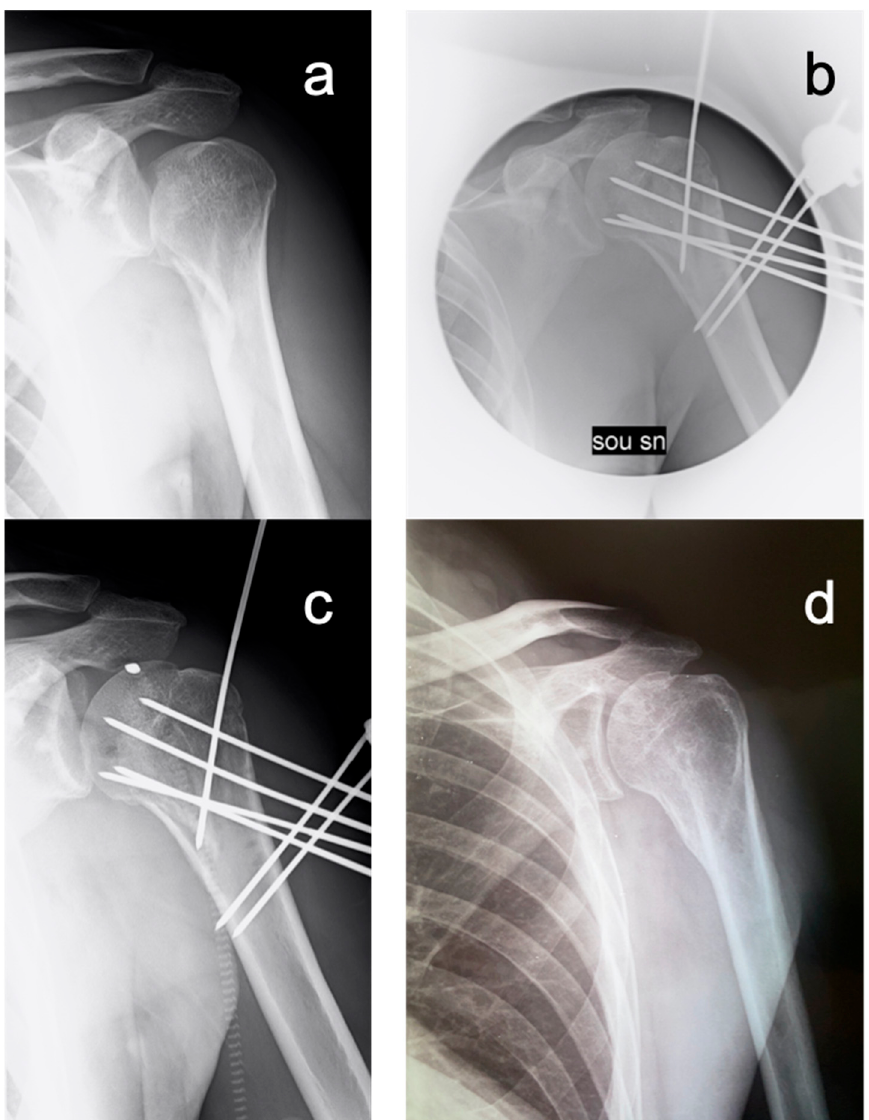
Figure 4. 53ys male patient who sustained a left three-part posterior fracture-dislocation of the humeral head. ( a ) Preoperative X-ray; ( b ) Postoperative X-ray; ( c ) 45 day-FU X-ray; ( d ) 48 months FU X-ray.